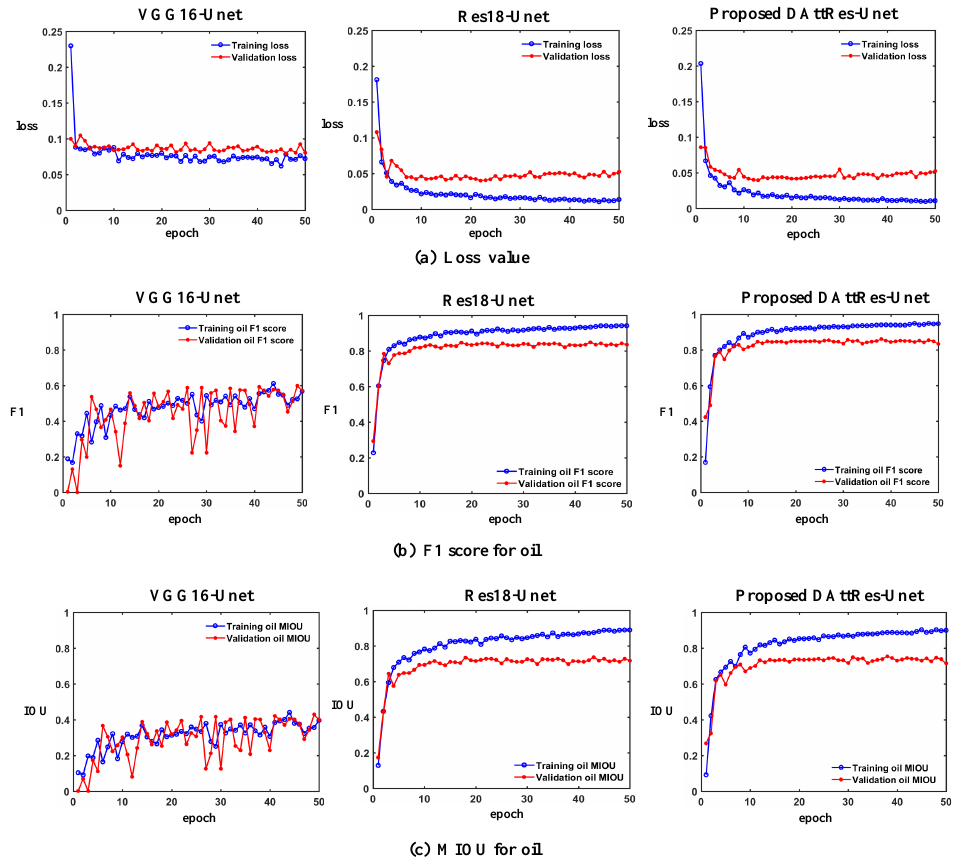
Figure 8. Loss, F 1 , and IOU curves of VGG16-Unet, Res18-Unet, and the proposed DAttRes-Unet. To compare the performance of the three models on segmented oil regions in more detail, we show the statistically calculated “ F 1 ” and “IOU” for oil pixels and the entire “Acc” using training, validation, and testing data in Table 2. Using the ResNet18 structure as a decoder achieves better performance than that of VGG16. As an example, the proposed DAtteRes-Unet model improves (“ F 1 ”, “IOU”, and “Acc”) by 17.14%, 23.10%, 1.77% com- pared to VGG16-Unet on the testing data. Due to the dual attention modules embedded in the decoder path, the proposed DAttRes-Unet model increases (“ F 1 ”, “IOU”, and “Acc”) by 4.04%, 5.98%, and 0.34% compared to Res-Unet on the testing data. These results imply that the attention module is conducive to the location of the oil